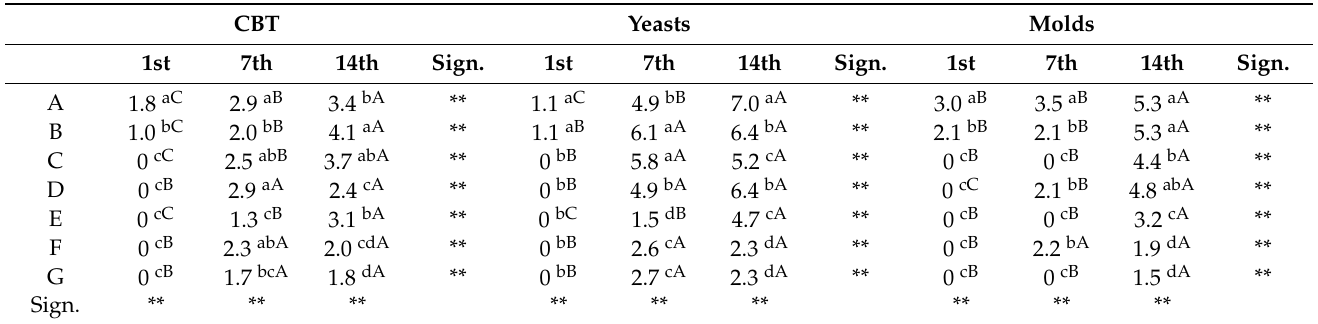
Table 8. The microbiological counts of minimally treated strawberries (Log10 CFU g − 1 ). CBT Yeasts